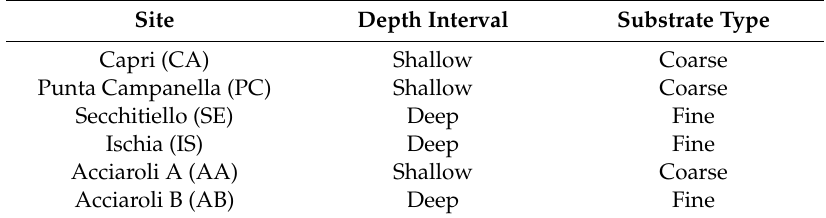
Table 2. Summary of prevalent ( > 75% of analysed video frames) depth interval and substrate type